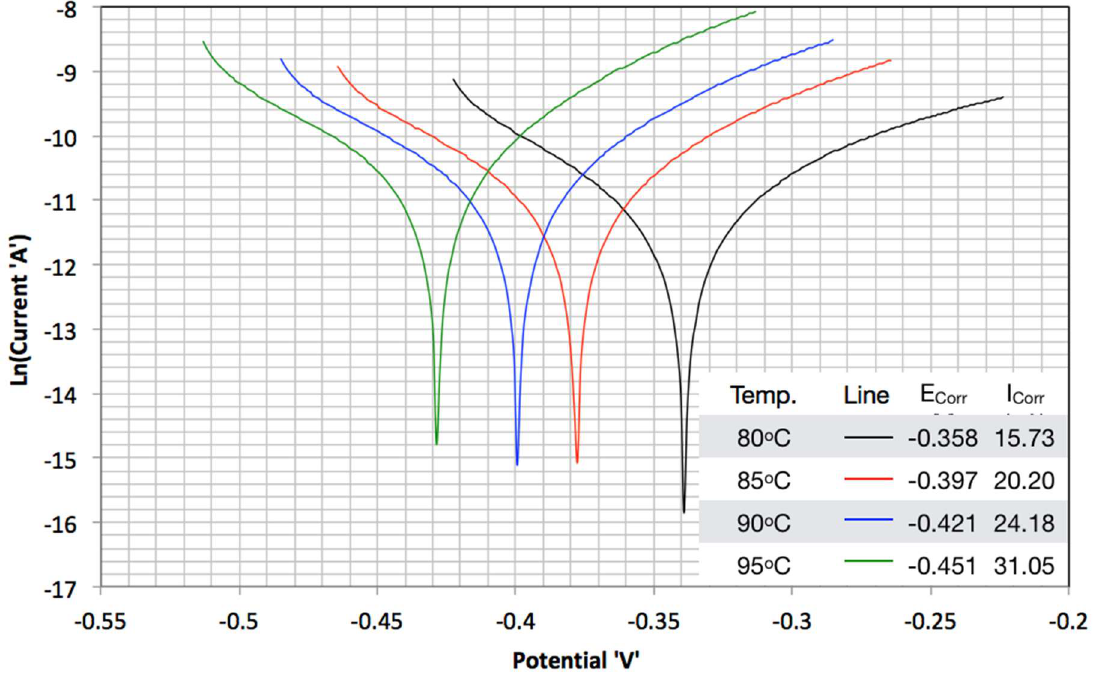
Figure 2. Tafel curves of pure [bmim][MS] without CO 2 at different temperatures. Scan rate = 1 mV/s. Fitted results for corrosion rates and potential are provided in the table.